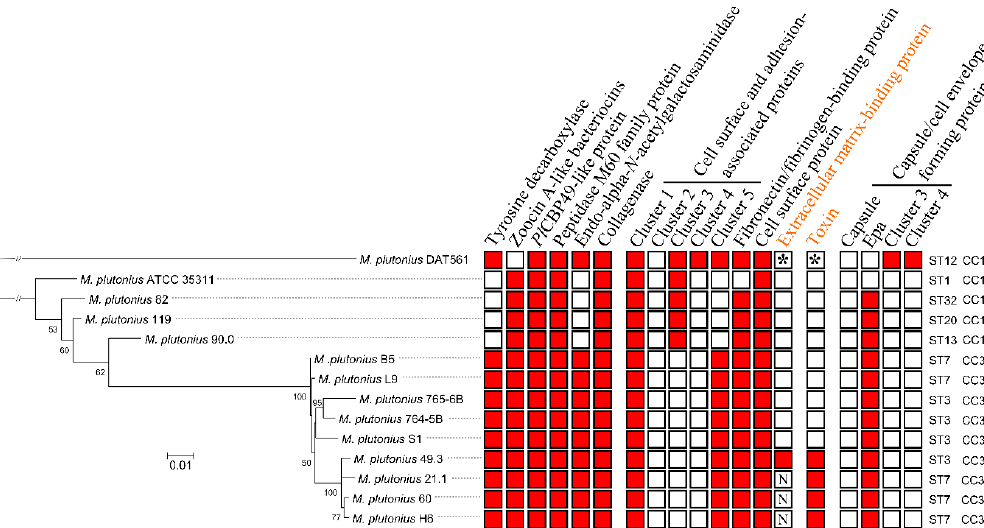
Figure 4. Gene content tree based on presence or absence of orthologous proteins. For constructing the phylogenetic tree, a presence/absence binary matrix was created from orthologous groups to calculate phylogeny with RAxML v8.1.3 [31]. The atypical strain M. plutonius DAT561 was used as the outgroup. Numbers at nodes are bootstrap values calculated from 1000 re-samplings to generate a majority consensus tree. The scale bar indicates divergence in presence or absence of proteins. STs are shown on the right. Color-filled boxes to the right of the organisms show the presence of the indicated proteins. Genes encoding putative virulence factors in red font are located on pMP19. An ‘N’ symbolizes that the respective open reading frame (ORF) is not complete due to a gap in the DNA sequence. An asterisk symbolizes that the respective ORF has been identified only in the second version of the DAT561 genome [47]. (Epa: enterococcal polysaccharide antigen).